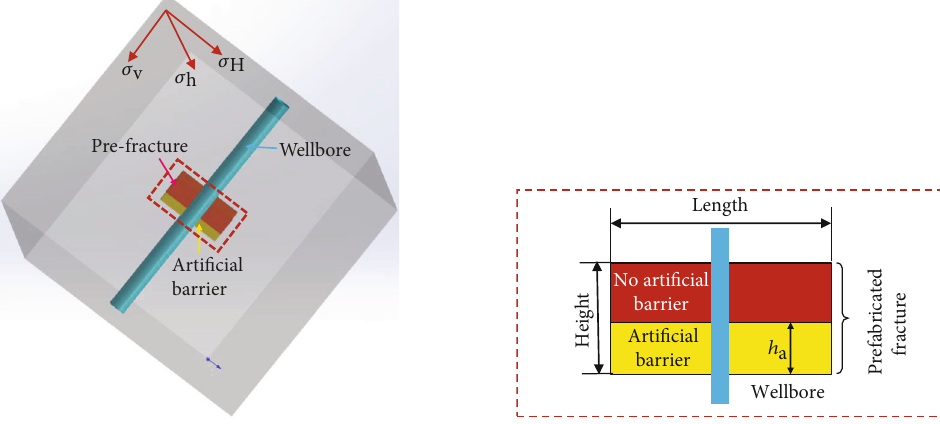
Figure 1: Sketch of experimental sample.